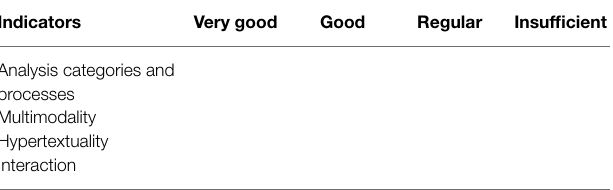
TABLE 1 | Evaluation rubric. Indicators Very good Good Regular Insufficient Analysis categories and processes Multimodality Hypertextuality Interaction Source. Own